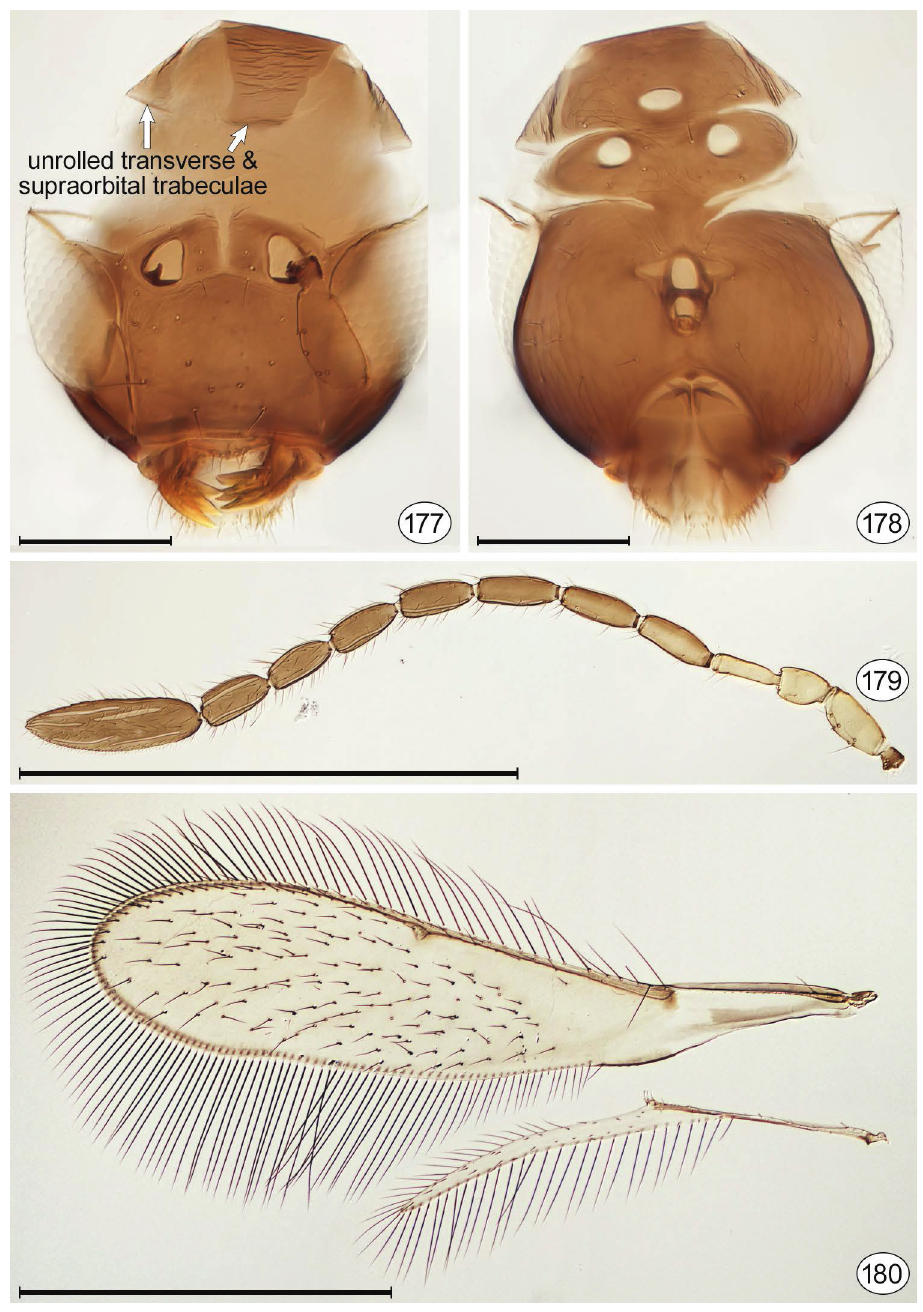
Figures 177–180. Borneomymar madagascar , female. 177 head, anterior (vertex detached anteriorly, with trabeculae unrolled) 178 head, posterior 179 antenna 180 wings. Scale bar for 177, 178 = 100 μm; 179, 180 = 500